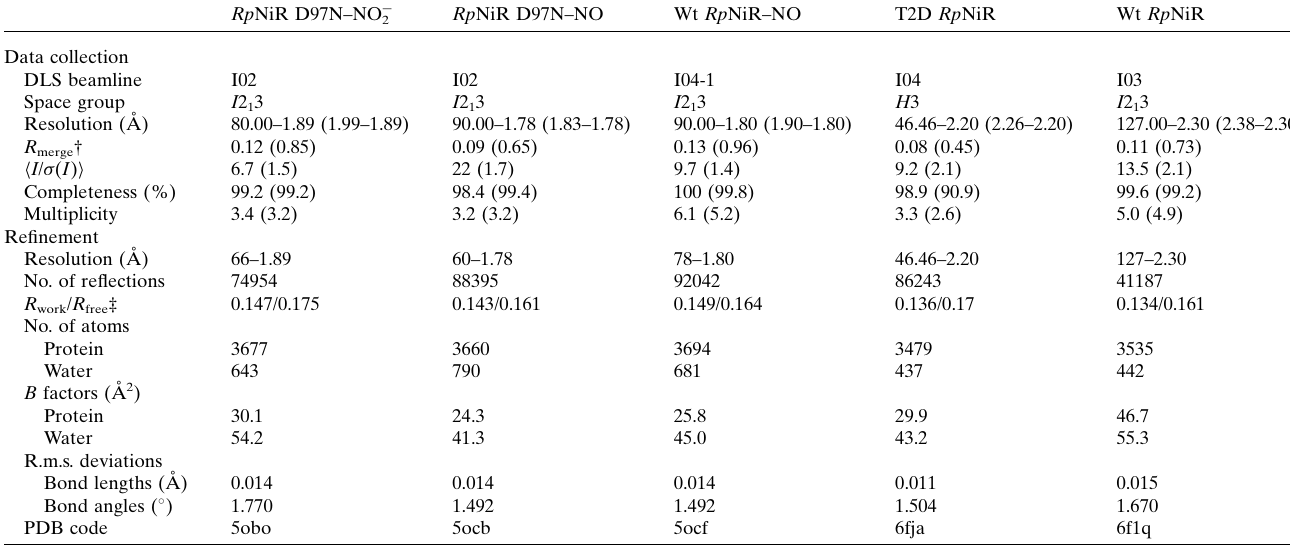
Table 1 Data-collection and refinement statistics. Values in parentheses are for the highest resolution shell. Rp NiR D97N–NO 2